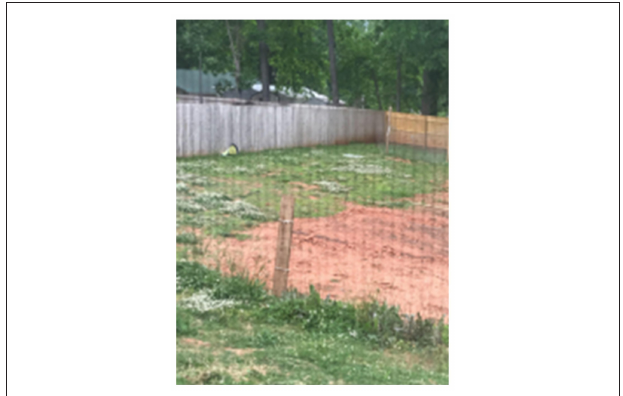
FIGURE 8 | “My physical active life: It’s quite literally not there besides walking around in my neighborhood some, that’s about it. This class has made me realize I really need to start working out more!!” (Cathy,